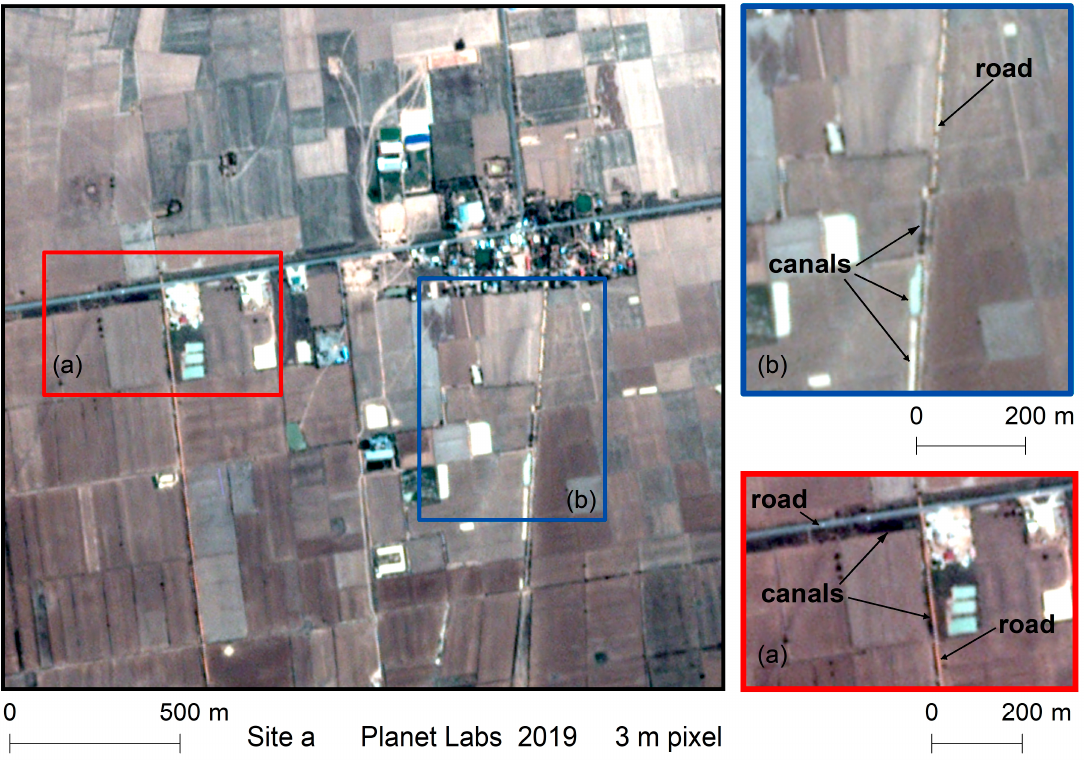
Figure 10. Modern imagery of the Banteay Meanchey Site a. Planet Labs imagery 3 m resolution. Red ( a ) and blue ( b ) insets provide closer view of canals and roads at the site.